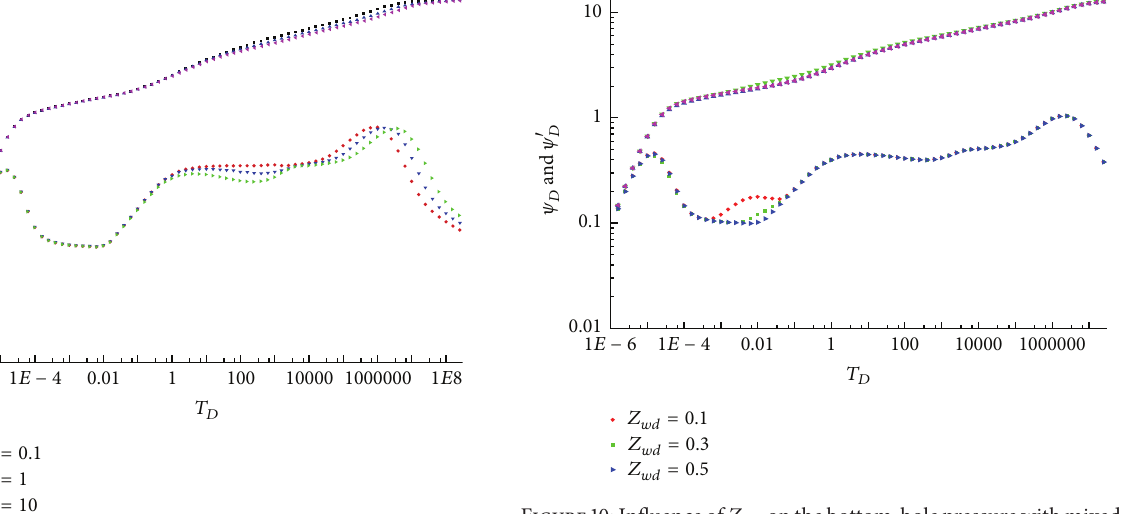
Figure 8: Influence of 𝛽 on the bottom-hole pressure with mixed boundary ( 𝜔 = 0.01 , 𝜆 = 300 , 𝐿 𝐷 = 2.5 , 𝑍 𝑤𝑑 = 0.5 , 𝐶 𝑑 = 0.0001 , = 50 ). 𝑠 = 1 , and 𝑟 𝑒𝐷